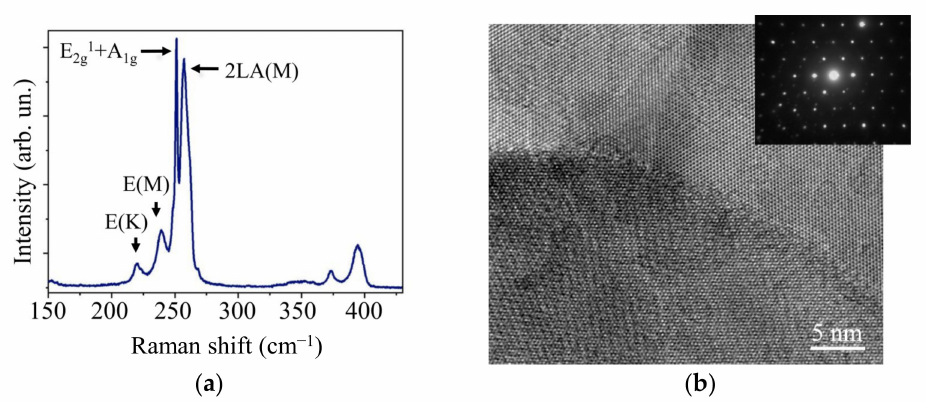
Figure 4. ( a ) Raman spectra and ( b ) HRTEM and SAED patterns of the WSe 2 film obtained by off-axis PLD.